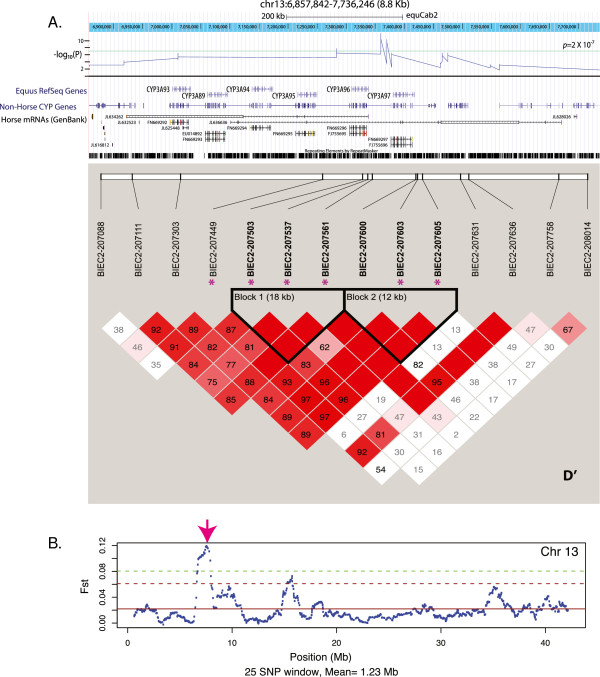
The placement of significant SNPs within the horse cytochrome P 450 genes. A. The horse CYP3A93-96 genes align to CYP3A5 (human and several other species, Bos CYP3A4) and downstream of the horse cluster, CYP3A6. The –logP for individual SNPs in the region is indicted. The green line represents genome wide significance. Linkage disequilibrium as D’ is shown. B. Shows the Fst nalysis of Chromosome 13 with the region of CYP3A indicated (arrow). The green dotted line represents 2 standard deviations from the mean Fst value for chromosome 13.